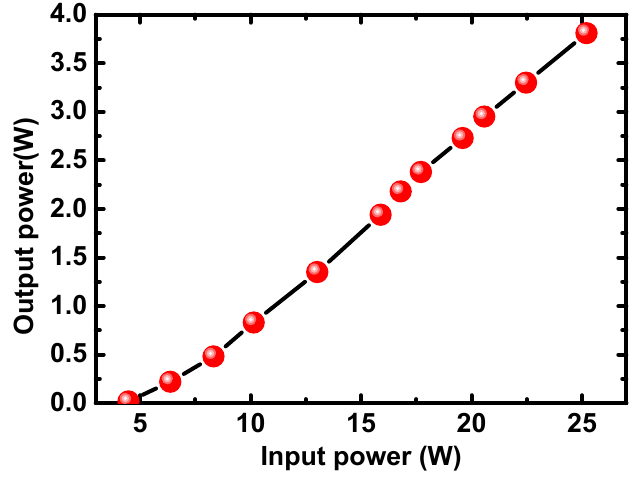
Figure 4. Output power at 1036 nm as a function of the 808 nm pump power.